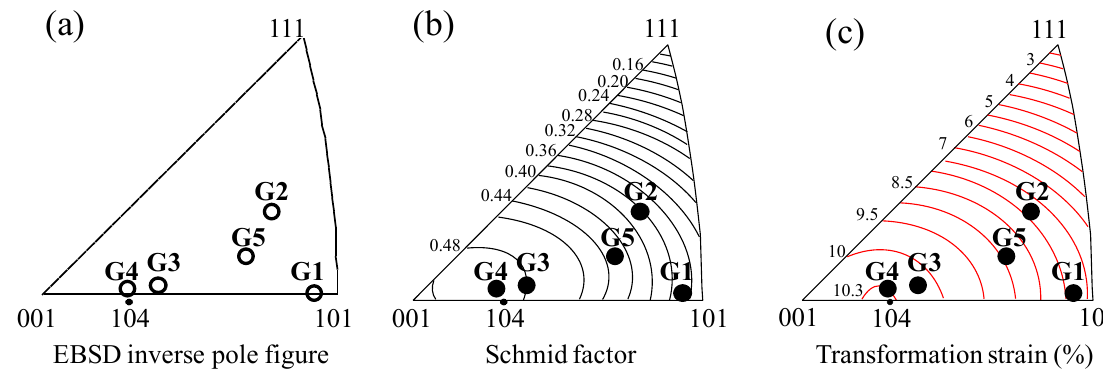
Figure 4. ( a ) EBSD inverse pole figure showing the orientation of the grains in the loading direction, which is indicated by G1, G2, G3, G4, and G5 in the EBSD image of Figure 3b; ( b ) Stereo-triangle showing the Schmid factor of the respective grains; ( c ) Stereo-triangle showing the transformation strain (%) of the respective